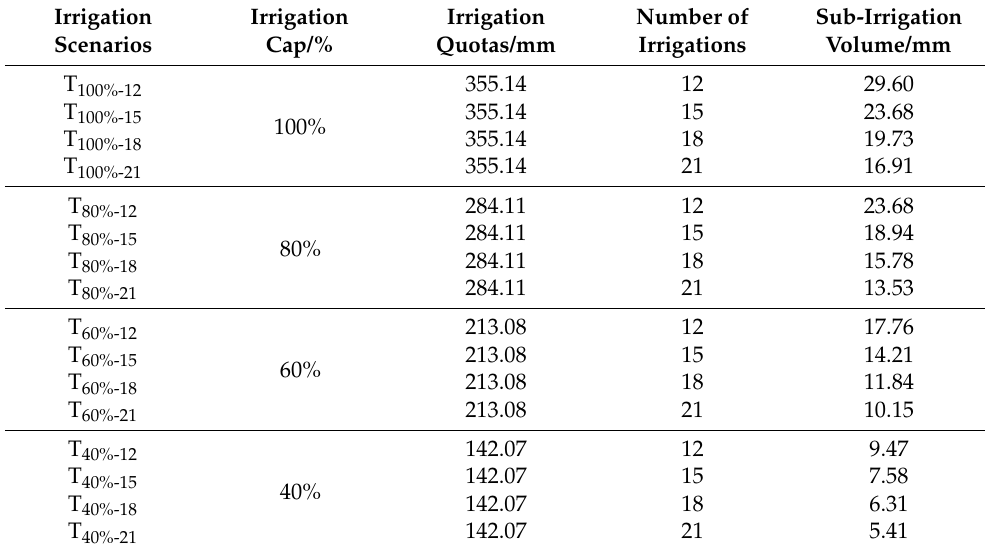
Table 2. Schedules of different irrigation systems for